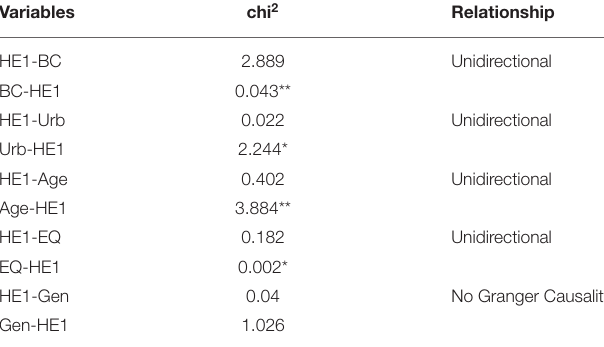
TABLE 6 | Granger causality, HE1.